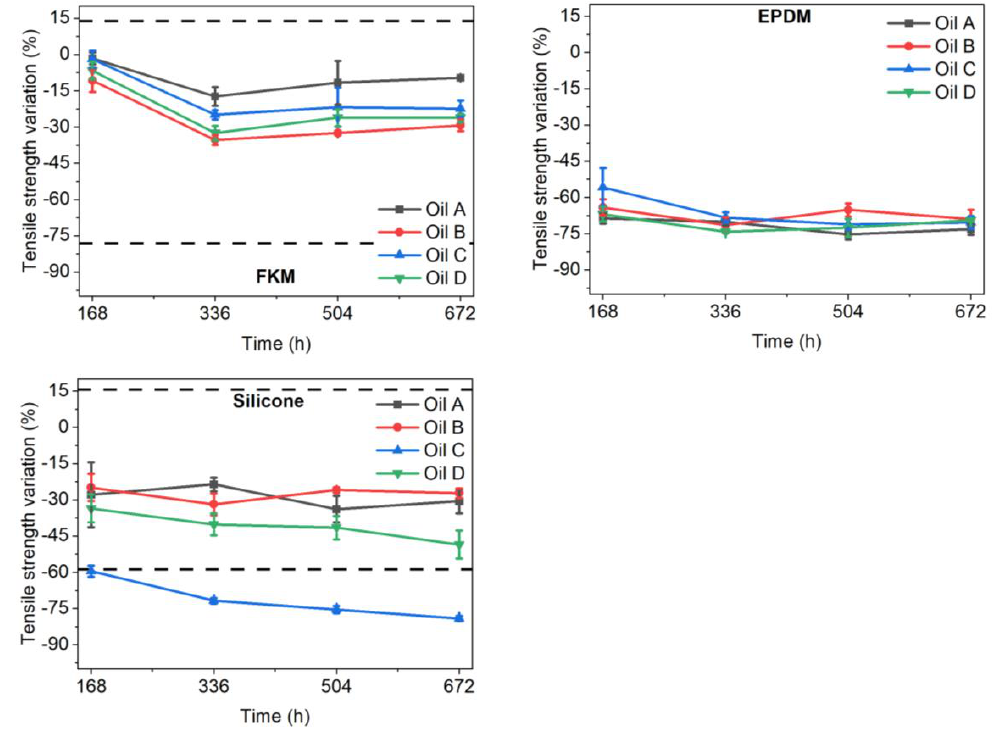
Figure 3. Changes in tensile strength (expressed as the ratio of the tensile strength variation to the initial tensile strength) of FKM, silicone, and EPDM after aging in oils A, B, C, and D.